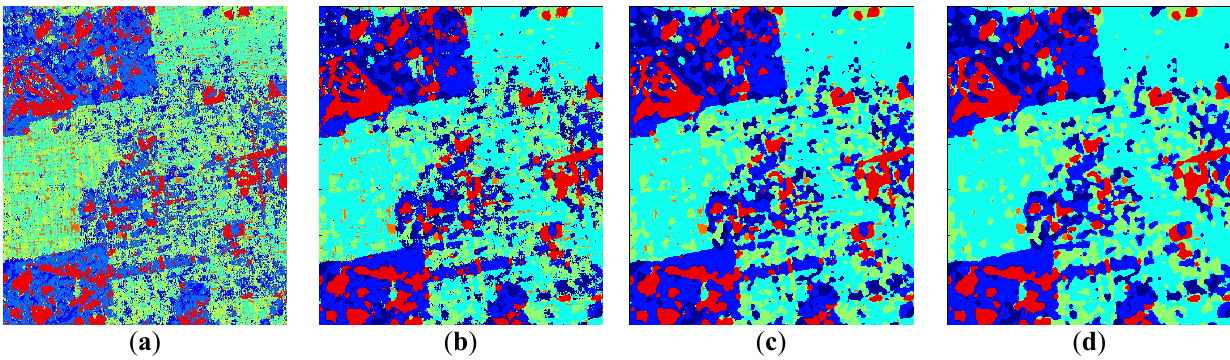
Figure 6. Expanded area corresponding to a city extracted from Figure 4. ( a ) Wishart with two iterations. ( b) HNN with one iteration. ( c ) ICM with one iteration. ( d ) Majority.